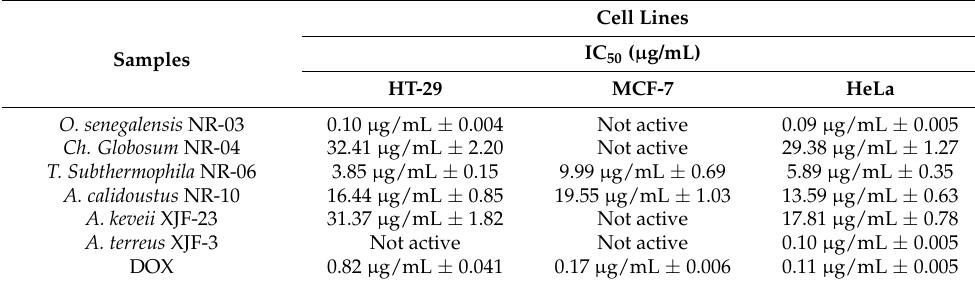
Table 6. Cytotoxic activity of total extracts obtained from fungal endophytes on human cancer cell lines HT-29, MCF-7 and HeLa ( n =